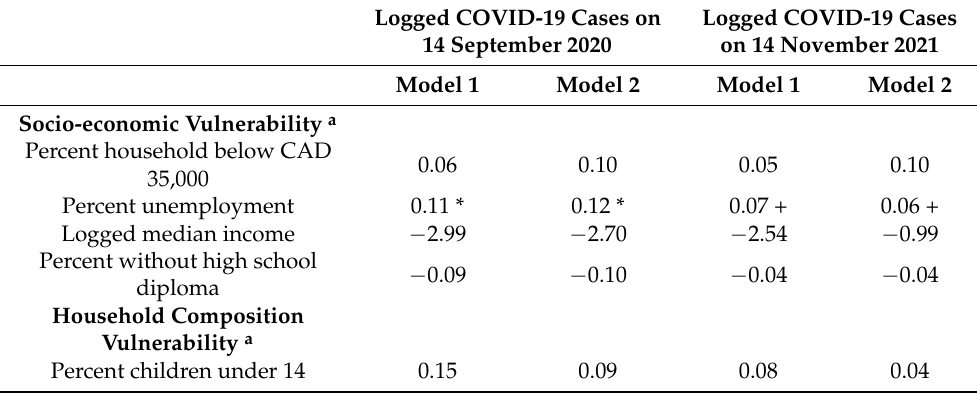
Table 2. Regression Results Predicting Logged COVID-19 Cases for 14 September 2020, and 14 November